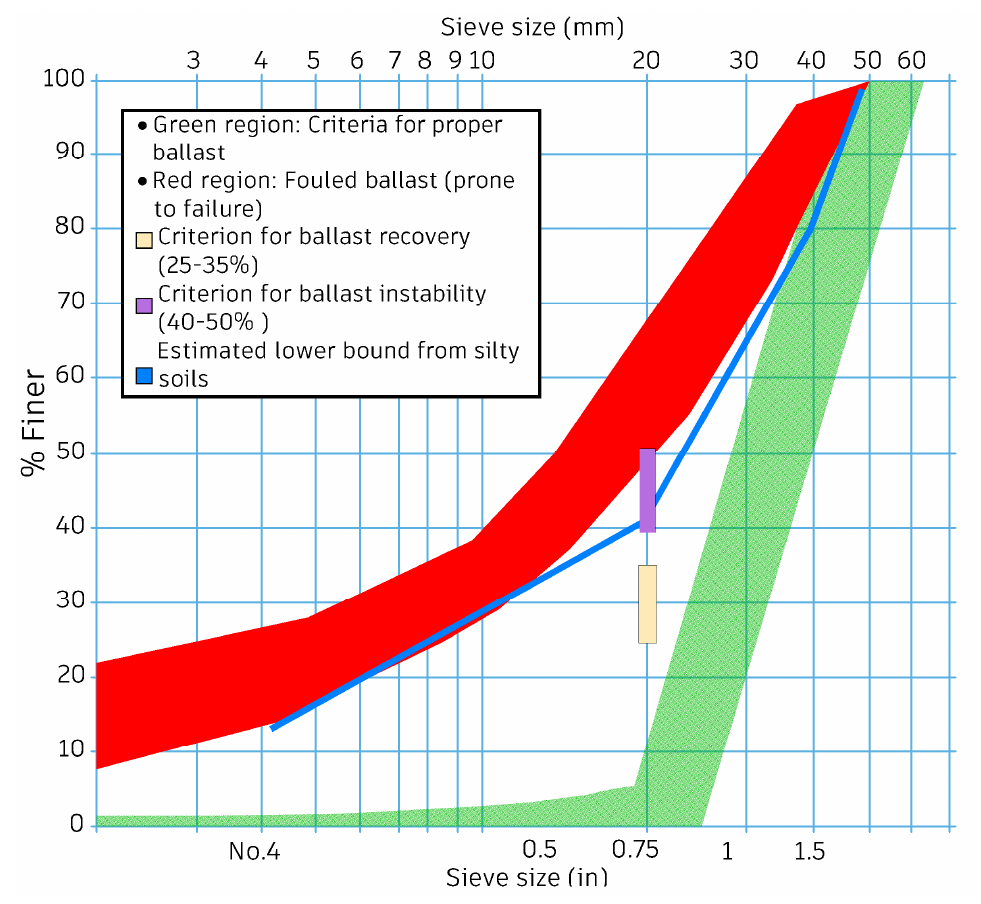
Figure 7. Ballast particle size gradation results with varied levels of clay fouling [31].